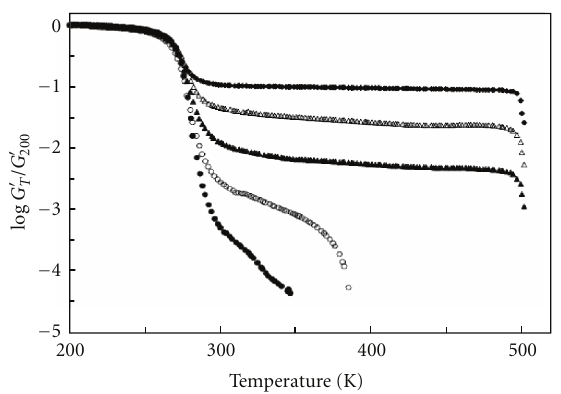
Figure 13: Logarithm of the normalized storage shear modulus (log G (cid:5) T /G (cid:5) 200 , where G (cid:5) 200 corresponds to the experimental value measured at 200K) versus temperature at 1 Hz for tunicin whiskers reinforced poly(S-co-BuA) nanocomposite films obtained by water evaporation and filled with 0 ( (cid:2) ), 1 ( (cid:3) ), 3 ( (cid:2) ), 6 ( ( (cid:3) ) of cellulose whiskers